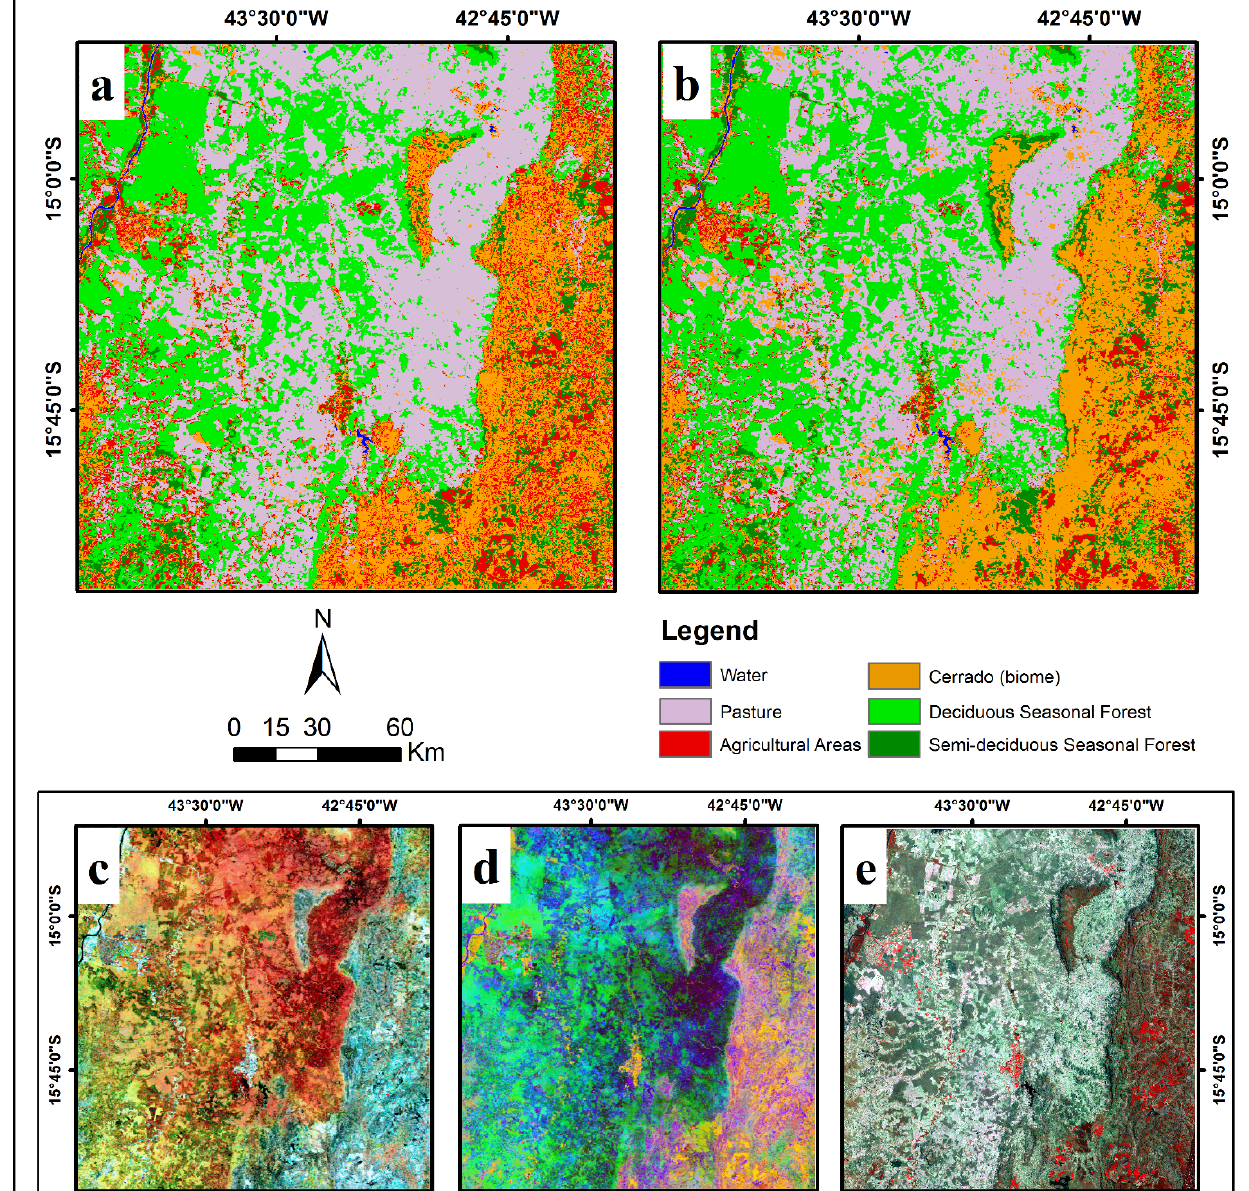
Figure 7. Classified maps built from ( a ) one or ( b ) three temporal curves and holding the remaining factors constant: ED, six classes (land use and land cover), and NDVI-MODIS input data. ( c ) RGB color composite of NDVI-MODIS images (12/27/2011–04/30/2012–09/05/2012). ( d ) MNF (components 1-2-4 as RGB), and ( e ) Landsat-TM (bands 4-5-3 as